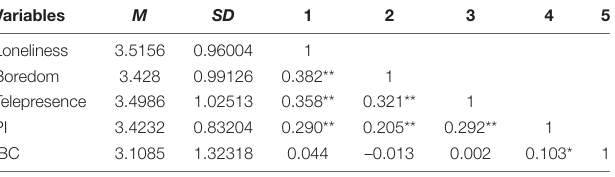
TABLE 2 | Correlations between variables.